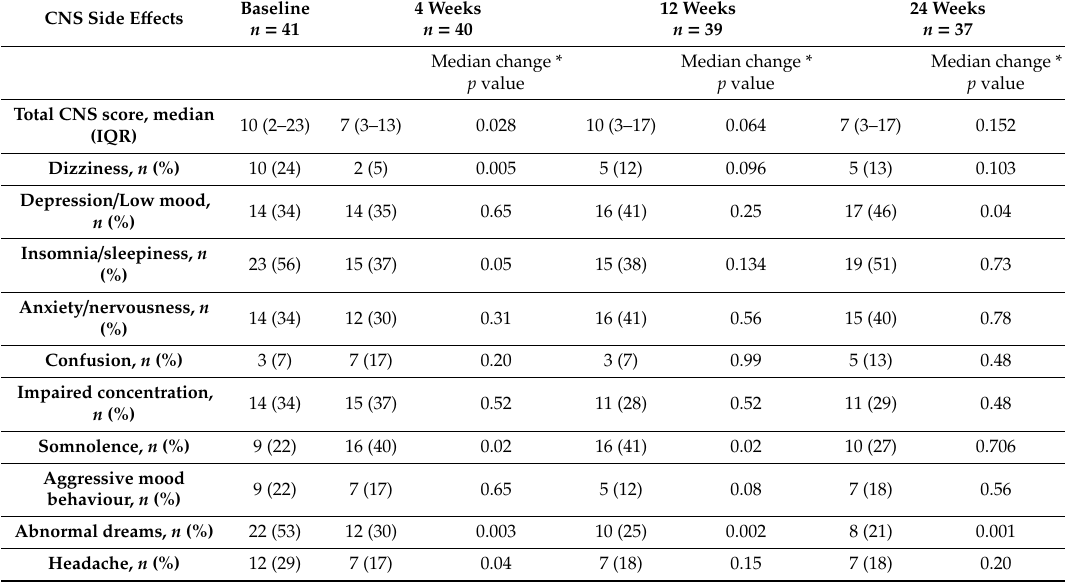
Table 1. Rates of grade 2–4 central nervous system (CNS) side e ff ects at week 4, 12 and 24 ( p values correspond to the di ff erence at each time point compared with event rates at